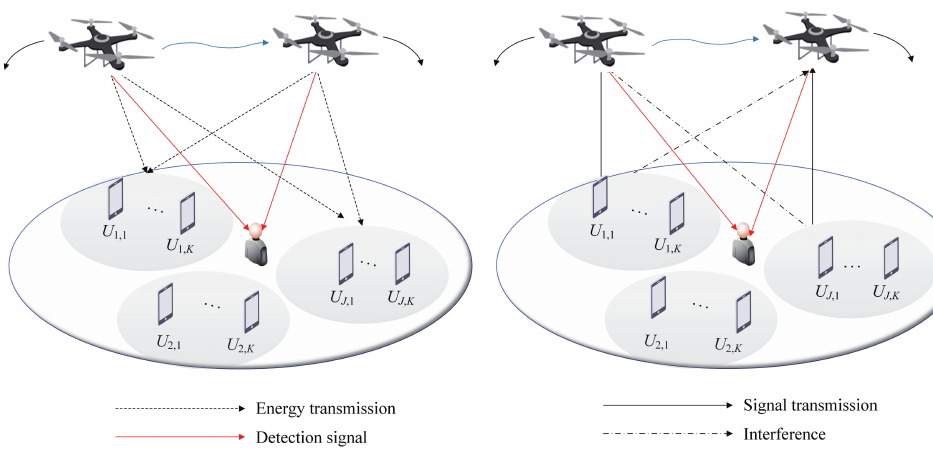
Figure 1. Multi-UAV-assisted covert communication